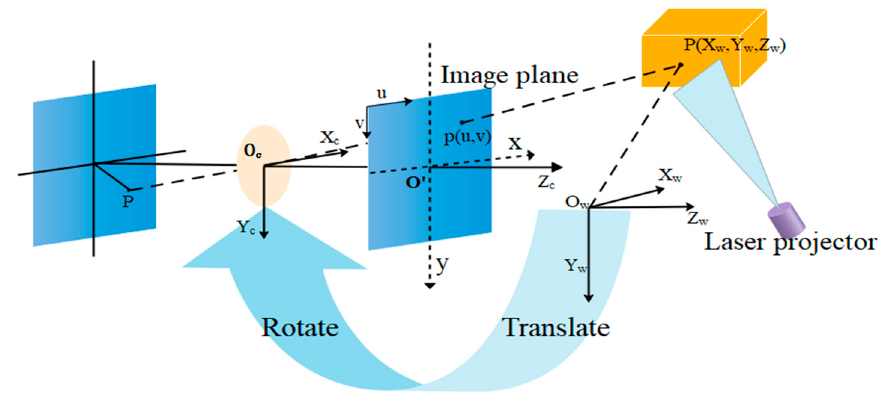
Figure 6. Perspective projection model of the visual sensor.